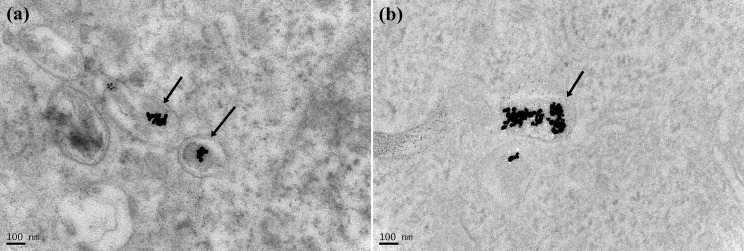
TEM images of MG63 after the uptake of GNPs.TEM images of MG63 cells after 20 hours of treatment with GNPs at concentrations of 1 ppm (a) and 10 ppm (b). GNPs aggregated within the cytoplamic vesicles shown with arrows.